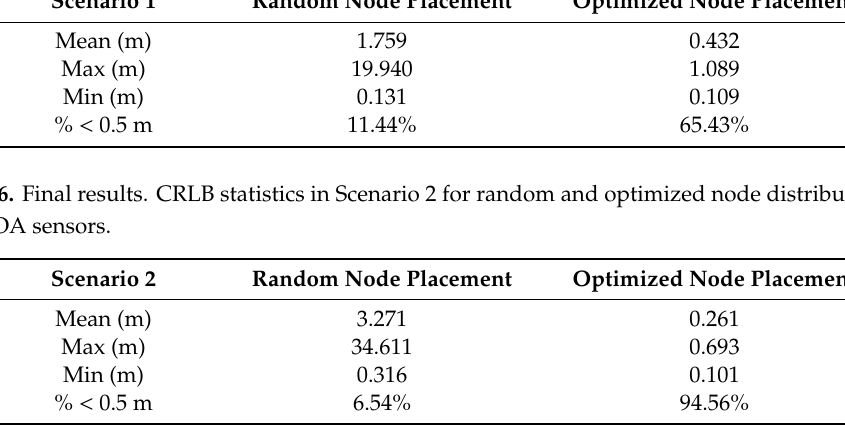
Table 5. Final results. CRLB statistics in Scenario 1 for random and optimized node distributions of 5 A-TDOA sensors.